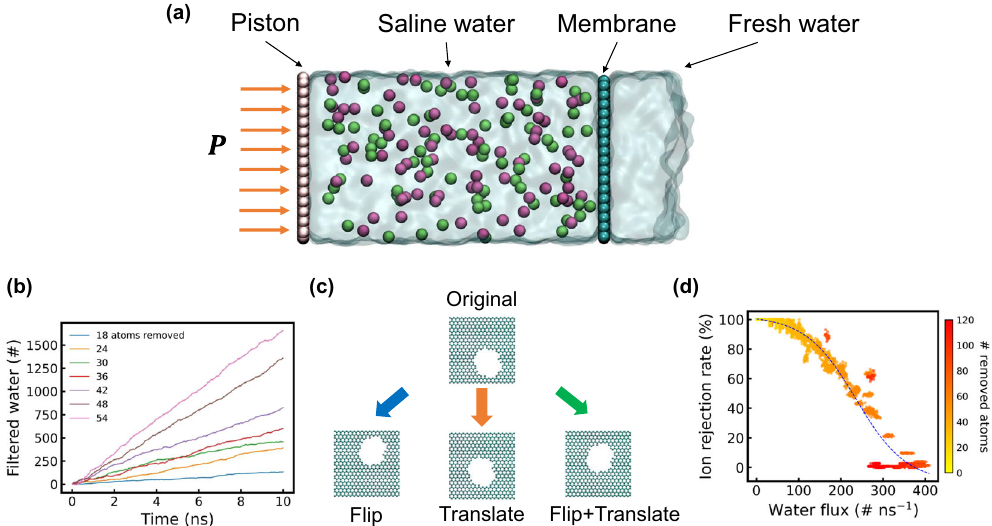
Fig. 2 Dataset generation using MD simulation and data processing. a Graphene nanoporous membrane water desalination system in MD simulation. b Number of fi ltered water molecules with respect to simulation time for pores with a different number of atoms removed. The slope of the least-squared regression line of each curve is the water fl ux. c Two data augmentation techniques: fl ip and translation. d Water fl ux and ion rejection rate distribution of the fi nal training dataset for predictive CNN model. The blue dashed line represents a reverse sigmoid curve fi tted in terms of water fl ux and ion rejection rate. Table 1. Performance of different models for graphene property prediction.